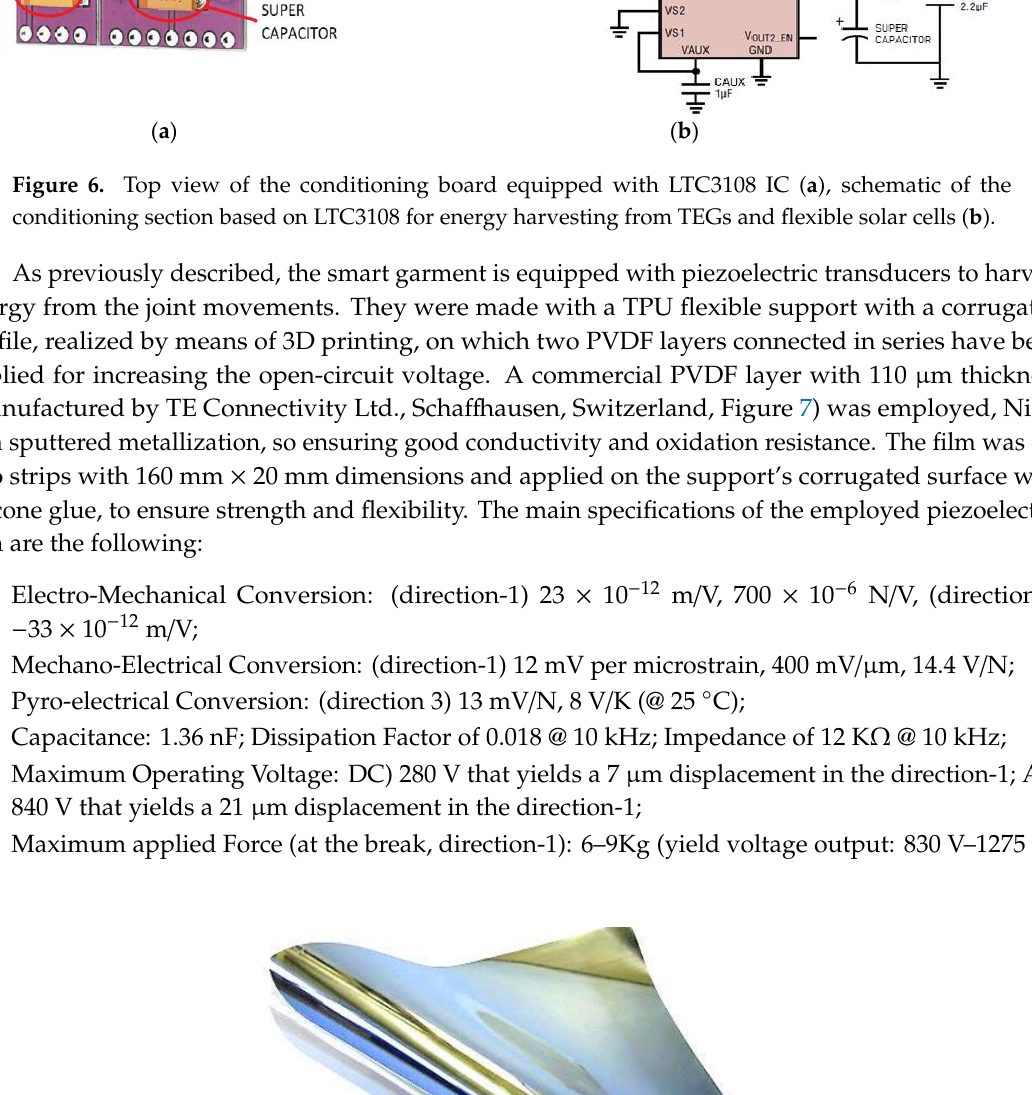
Figure 6. Top view of the conditioning board equipped with LTC3108 IC ( a ), schematic of the